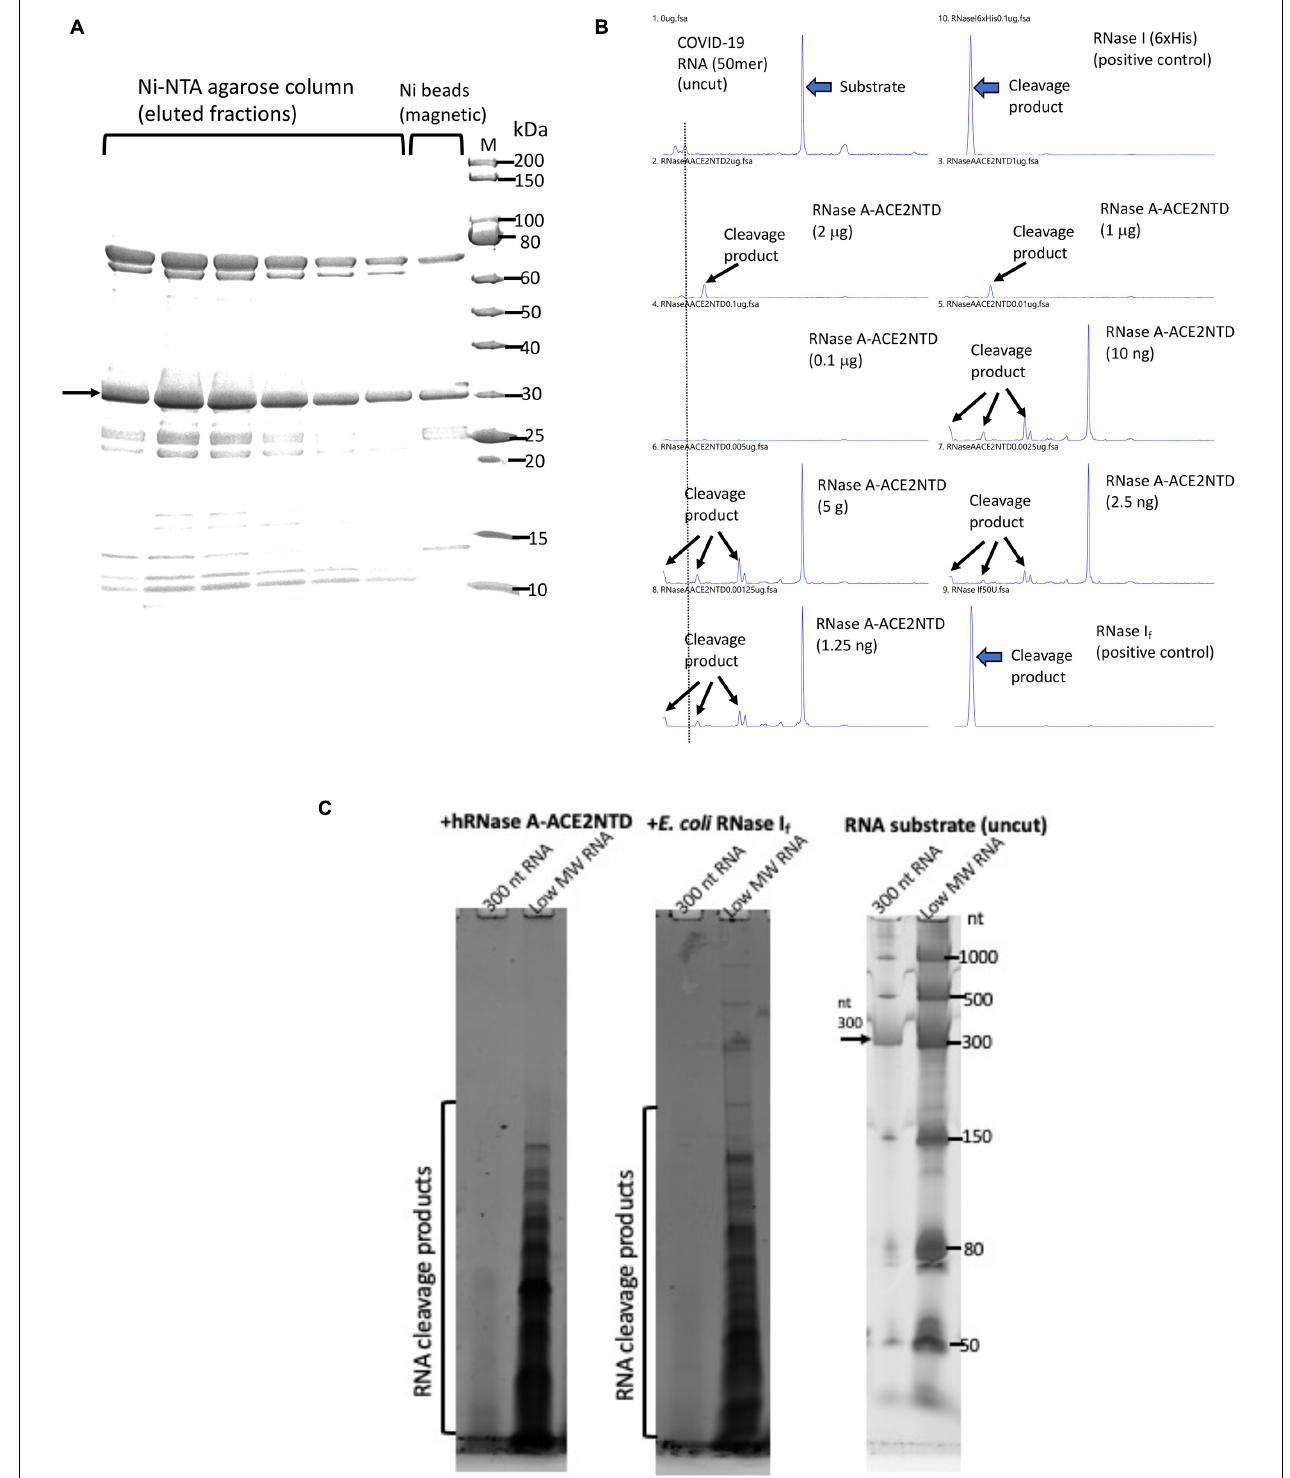
FIGURE 7 | SDS-PAGE analysis of purified hRNase A-ACE2NTD150 (6 × His) and ribonuclease activity assays. (A) Partially purified hRNase A-ACE2NTD150 (6 × His) (no signal peptide) by Ni-NTA agarose column chromatography or by binding to Ni magnetic beads. (B) RNase activity on FAM-labeled SARS-CoV-2 RNA (50 mer). Arrows indicate the substrate and cleavage products in the CE assay. (C) RNase activity assay on a 300-nt RNA and low MW RNA ladder as analyzed on a 6% PAG-urea gel (stained with SYBR green and visualized on a Typhoon Imager).